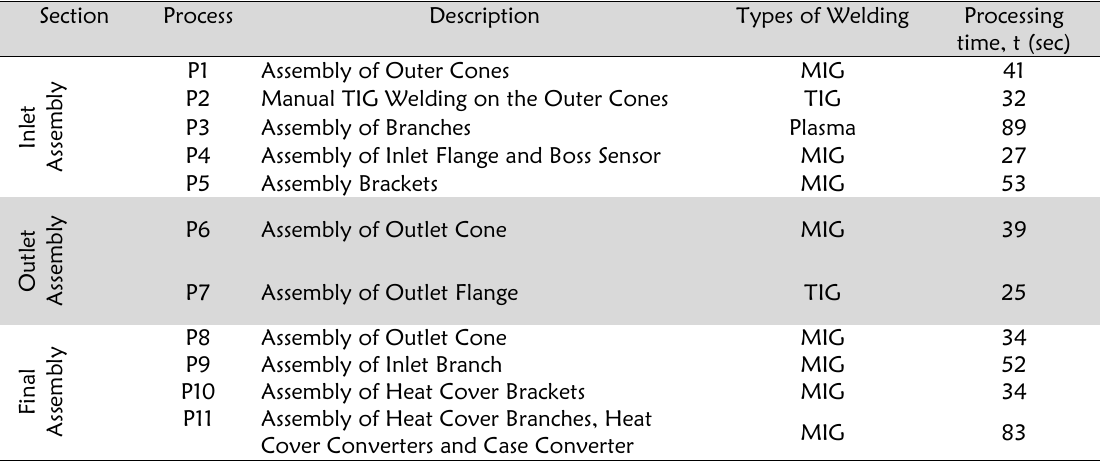
Table 1: Description of welding operations and associated processing